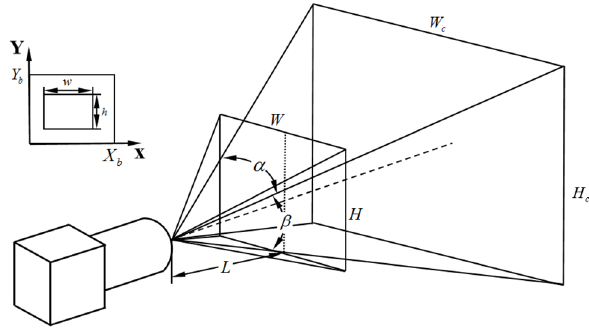
Figure 6. Schematic diagram of perspective transformation.